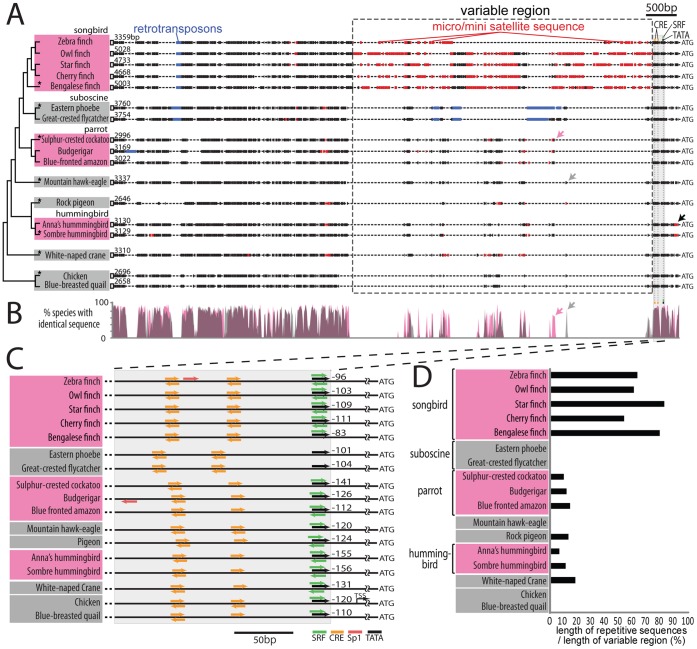
Upstream sequences of dusp1 among species.(A) Schematic of the ∼3 kb upstream region of dusp1 in vocal learning and vocal non-learning avian species (range 2,646 to 5,048 bp depending on species). The conserved region used to clone the sequence among the avian species is indicated by an open box at the 5′ end. ATG is the initiation codon of the protein. Red boxes, repetitive microsatellite sequences. Blue boxes, retrotransposon sequences (MIR3/LINE-like and CR1/SINE-like elements in the songbirds, suboscines, and one parrot species). Arrows indicate the similar sequences found only in vocal learners (pink) or in vocal non-learners (grey). The black arrow indicates microsatellite sequence close to the start codon found in hummingbirds. Grey shaded region, proximal regulatory region where the putative cis-binding sites are found. (B) % of species with identical sequences among at least 2–3 vocal learners (pink) or 3 or more vocal non-learner lineages (grey). Overlap is pinkish-grey. (C) Region within 300 bp of the transcription start site (ATG), showing putative cis-binding sites for activity-dependent transcription factors (color-coded for individual transcription factors); direction of arrows indicates strand on which the binding motif was found (forward + strand; backward - strand). Translation start site (TSS) annotated in chicken genome. (D) Proportion of repetitive microsatellite sequence in the variable region between species (dashed boxed region in (A)).